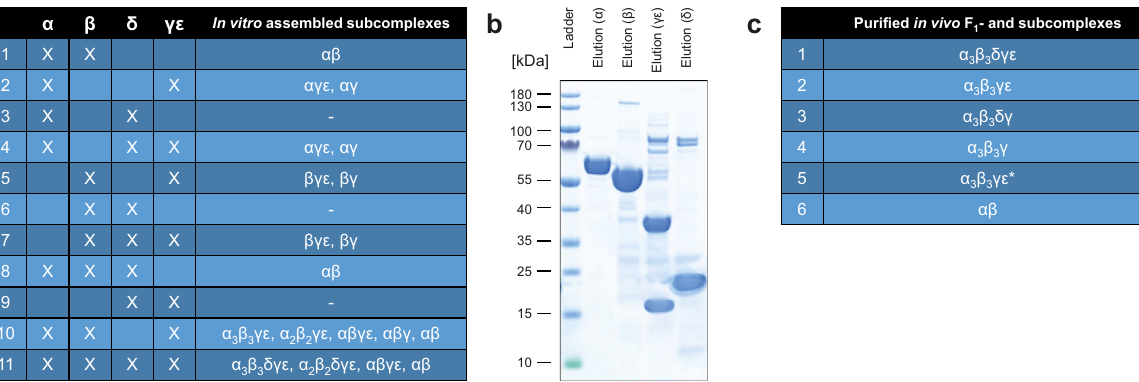
Fig. 2 Summary of all subcomplexes obtained in vitro and in cellula . a List of all subcomplexes observed with LILBID-MS after in vitro assembly of isolated subunits in the presence of 2 mM ATP and 2 mM MgCl 2 . b SDS-PAGE (NuPAGE 4 – 12% Bis-TRIS) of single puri fi ed subunits α , β , γε , and δ . Af fi nity puri fi cation of α with Strep-Tactin- and β , γε , and δ with Ni-chelating chromatography. N = 3 independent experiments. c List of in E. coli heterologously puri fi ed F 1 and subcomplexes. All complexes were analyzed with LILBID-MS and SDS-PAGE (Supplementary Fig. 7). Source data underlying Fig. 2a are provided as a Source Data fi le.